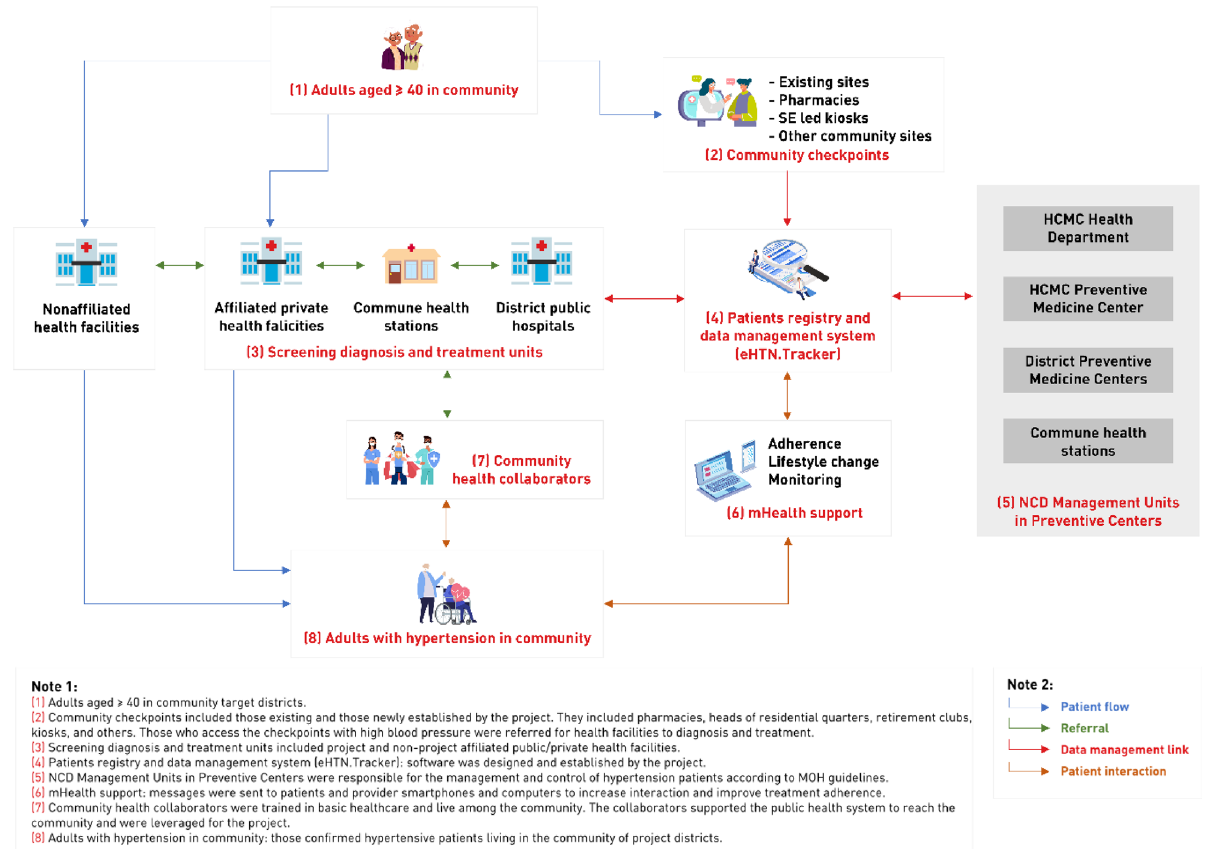
Figure 2. Diagram of the Communities for Healthy Hearts health care delivery model. Source : PATH.